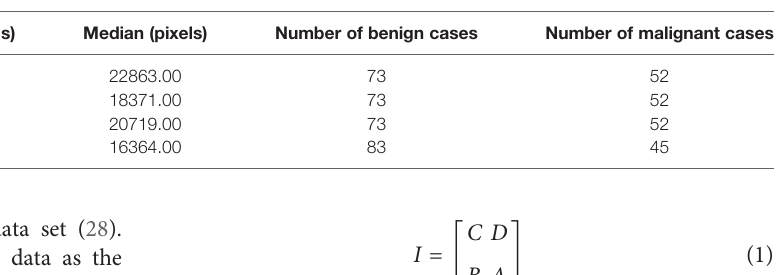
TABLE 1 | The characteristics of the tumors in each